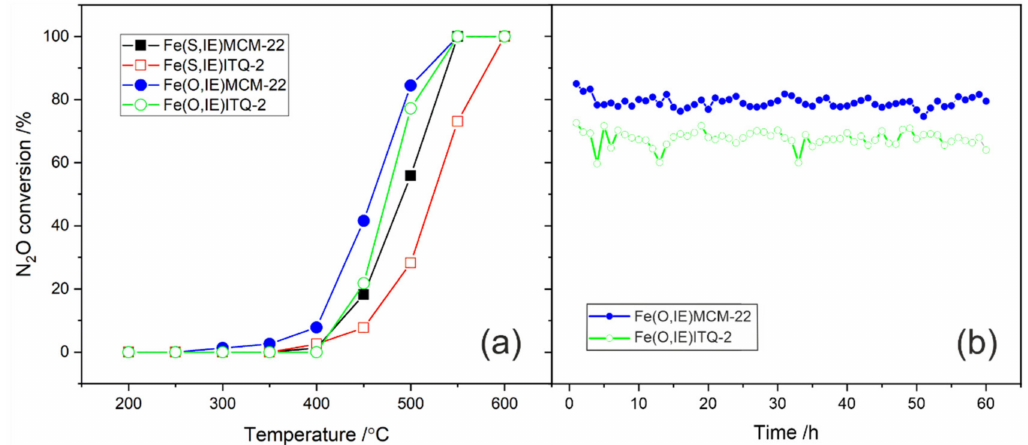
Figure 5. N 2 O conversion ( a ) versus temperature for the MCM-22 and ITQ-2 samples modified with FeSO 4 · 7H 2 O and [Fe 3 (OCOCH 3 ) 7 · OH · 2H 2 O]NO 3 by ion-exchange and ( b ) versus time for the samples Fe(O,IE)MCM-22 and Fe(O,IE)ITQ-2 at 500 ◦